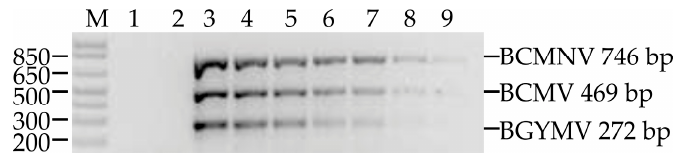
Figure 3. Detection of BCMV, BCMNV and BGYMV in composite samples. M: Molecular marker 1 kb plus DNA ladder. Lane 1: non ‐ template control; lane 2: negative control (cDNA from healthy plants); lane 3: positive control (cDNA from common bean infected with BCMV, BCMNV and BGYMV); lanes 4, 5, 6, 7, 8 and 9: dilution 1:1, 1:2, 1:3, 1:4, 1:5, and 1:6, respectively.